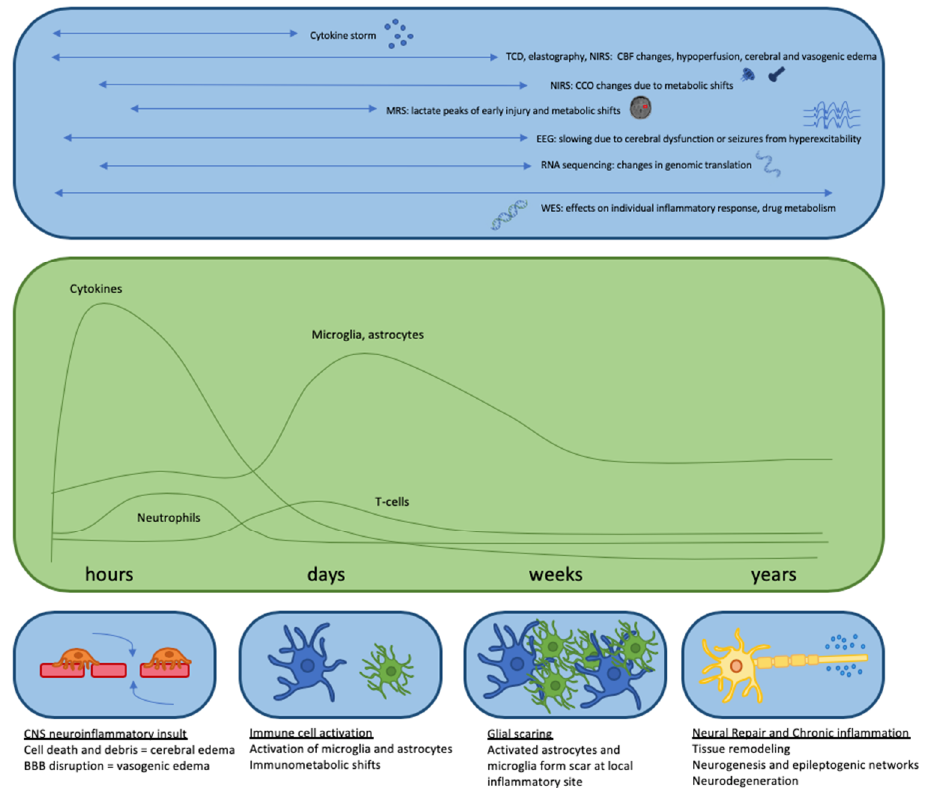
Figure 3. Time course depicting cellular CNS response to neuroinflammation and activation of immune cells, with timing of multi-modal monitoring. Top panel indicates di ff erent modes of monitoring during each stage of the CNS inflammatory response, and markers than can be measured. Middle panel indicates activation of di ff erent immune cells over time in response to a neuroinflammatory stimuli. Bottom panel indicates cellular and molecular changes over